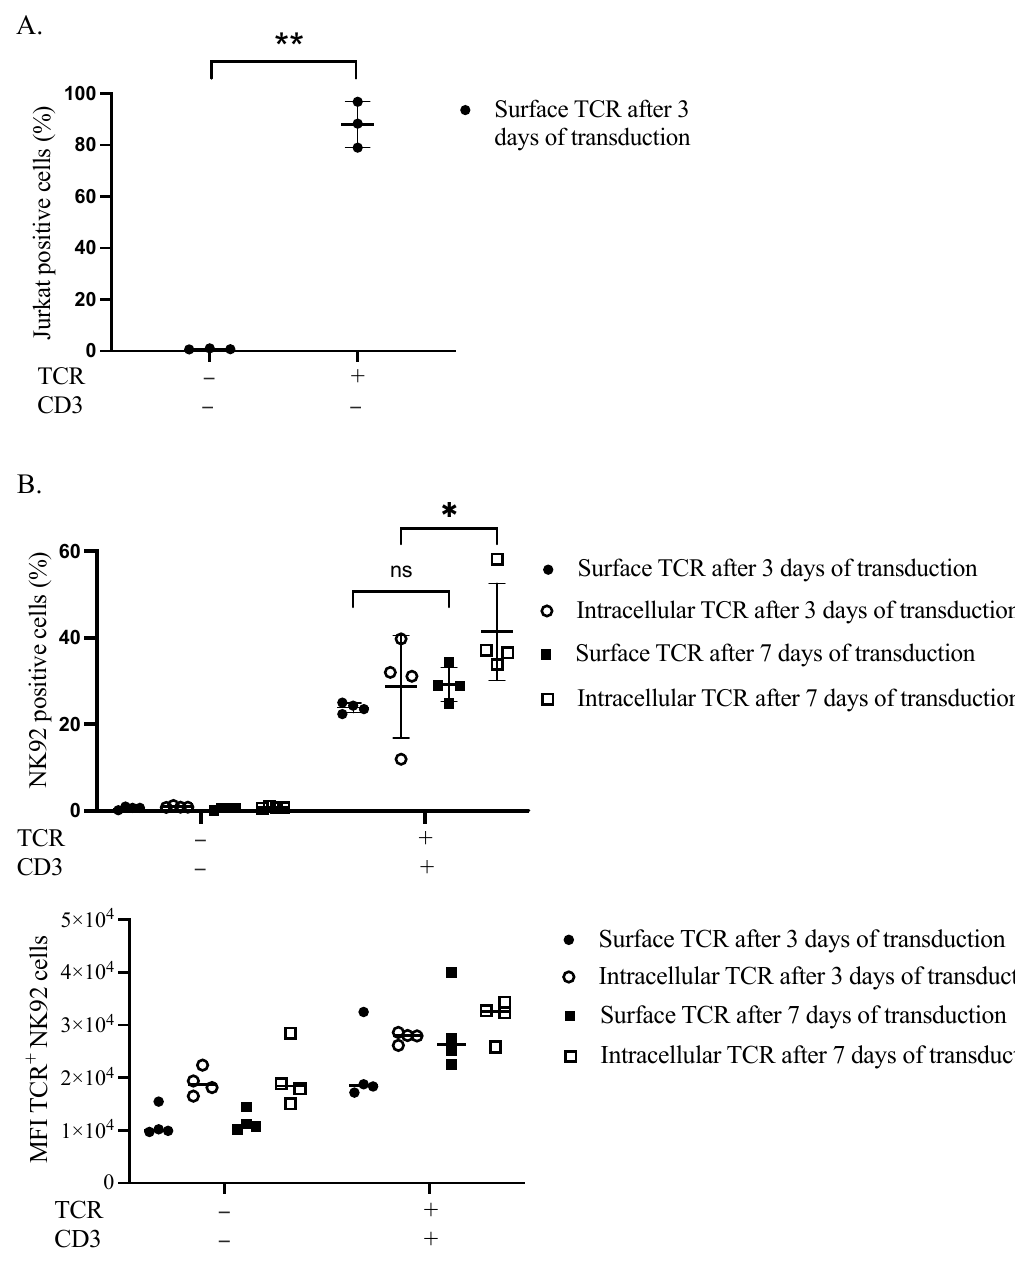
Figure 1. Retentions and dynamics of TCR expression in Jurkat and NK92 cells. ( A ) Confirmation of TCR expression in Jurkat cells. Three days after transduction, cells were harvested and stained for flow cytometry to assess the expression of TCR on the surface of Jurkat cells. Live cells were pre-gated during the analysis of acquired data. Three independent experiments were performed. The ** indicates a statistically significant p < 0.01. ( B ) Dynamics of transgene expression in NK92 cells. NK92 cells were transduced with TCR and then the day after they were transduced with CD3 subunits lentiviral vector. Three- and seven-days post-transduction, cells were harvested and stained for flow cytometry to see the expression of TCR. Live cells were pre-gated during the analysis of acquired data. Four experiments with sequential transduction and single transduction were carried out. ns indicates not significant. * p <